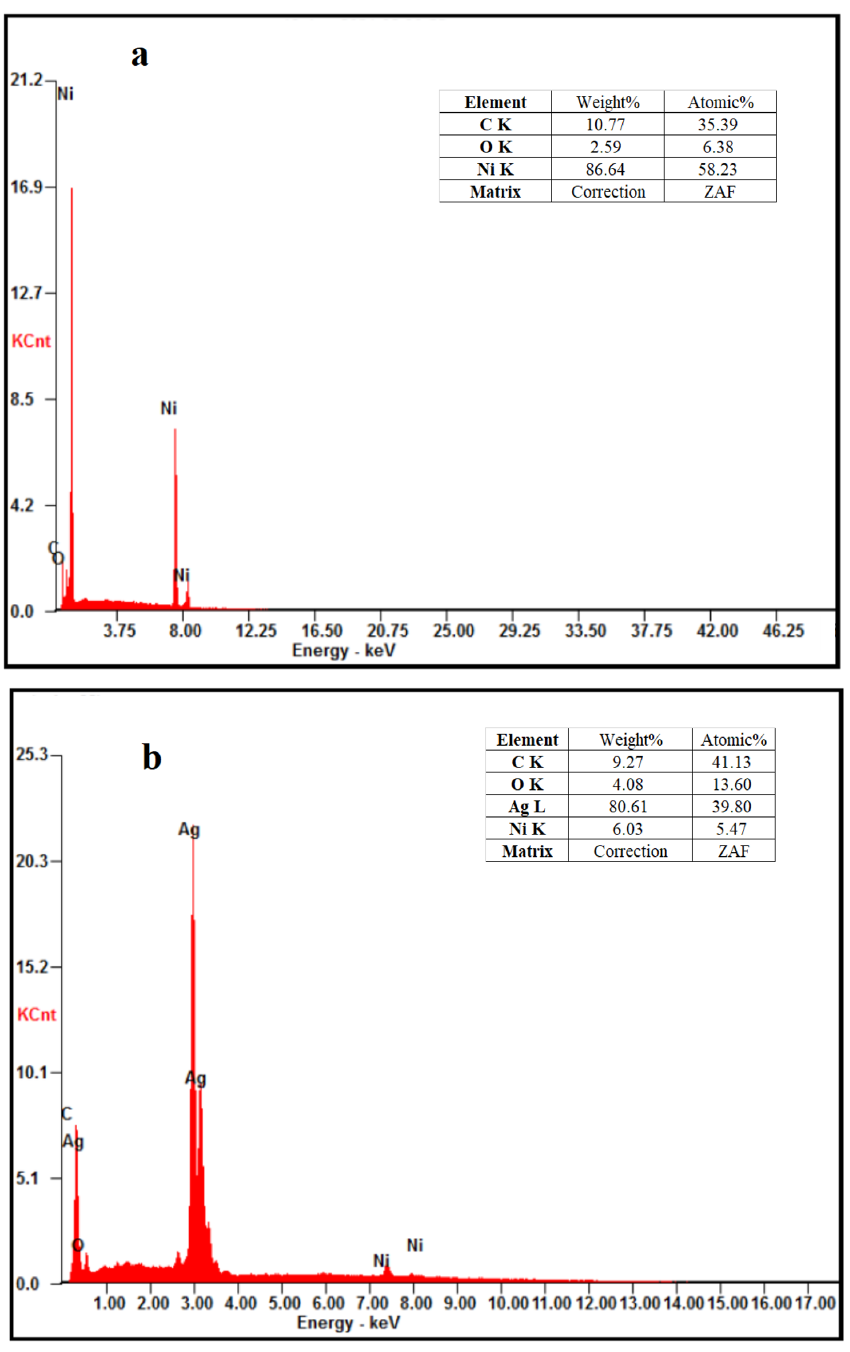
Figure 12. ( a ) EDS of Ni/C powders post-HMT for 1000 h; ( b ) EDS of Ag/Ni/C powders post-HMT for 1000 h.